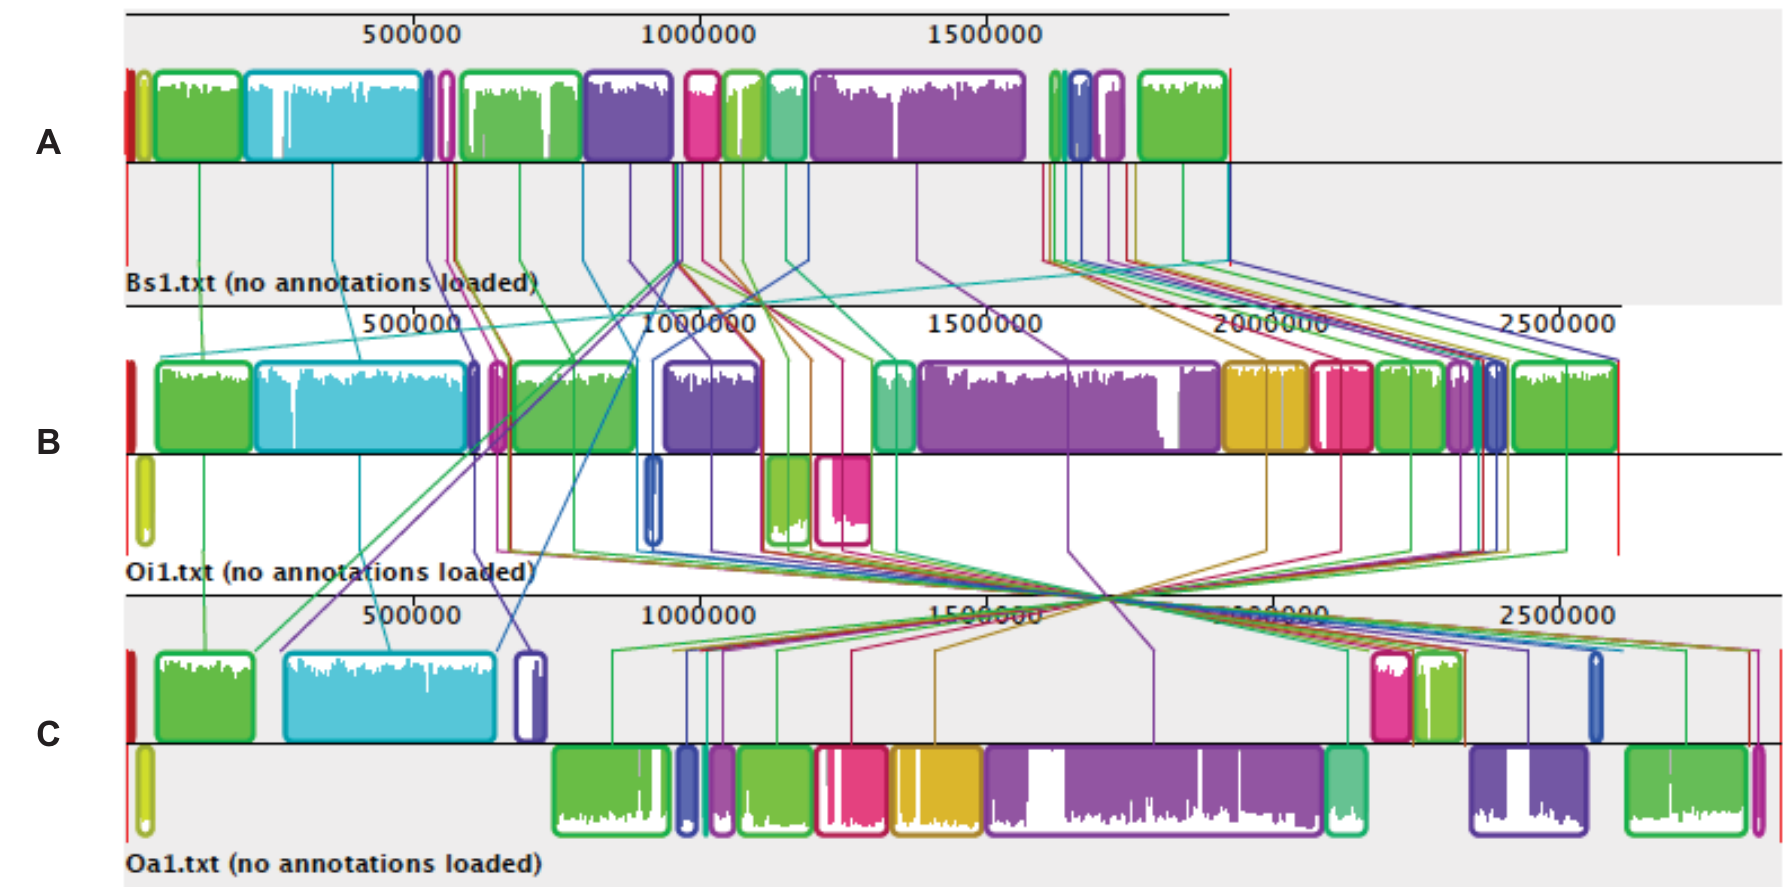
Figure 2. Gene alignment of large chromosome (ChrI) of B. suis , O. intermedium and O. anthropi using MAUVE multiple alignments. Colored outlined blocks surround regions of the genome sequence that aligned to part of another genome. The colored bars inside the blocks are related to the level of sequence similarities. Lines link blocks with homology between two genomes. Genome from top to